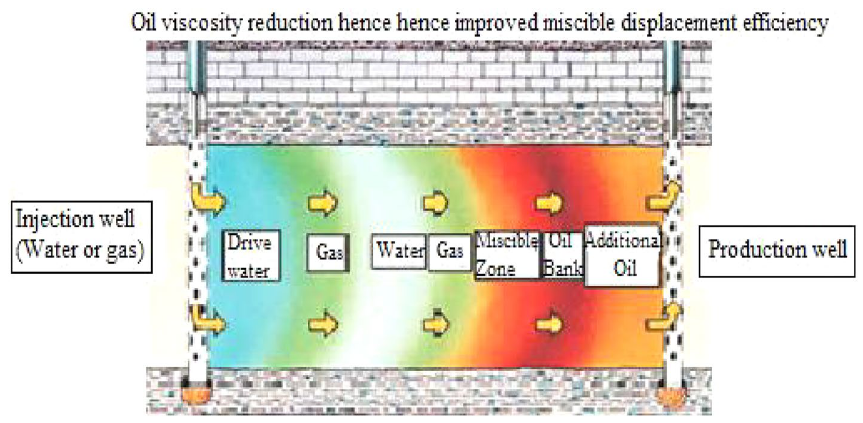
Fig. 2 Gas miscible